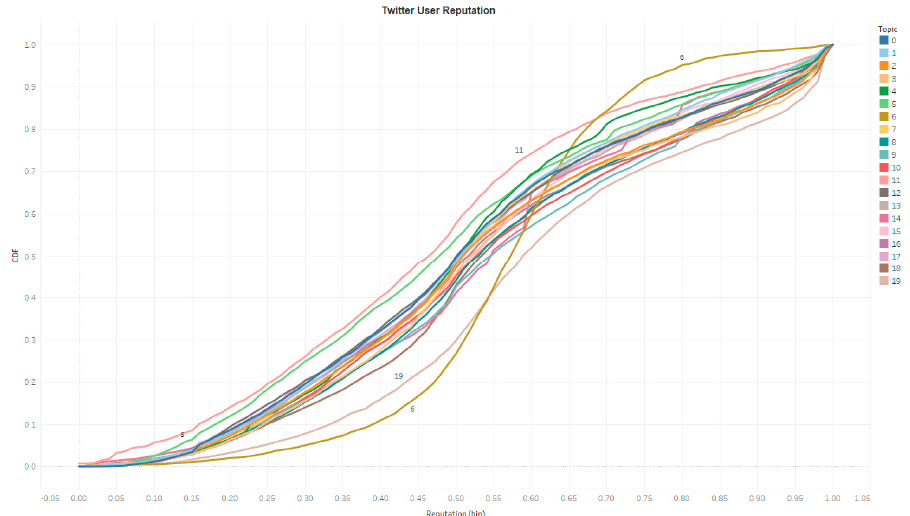
Figure 9. Reputation of Twitter users. ISPRS Int. J. Geo-Inf. 2019 , 8 , 436